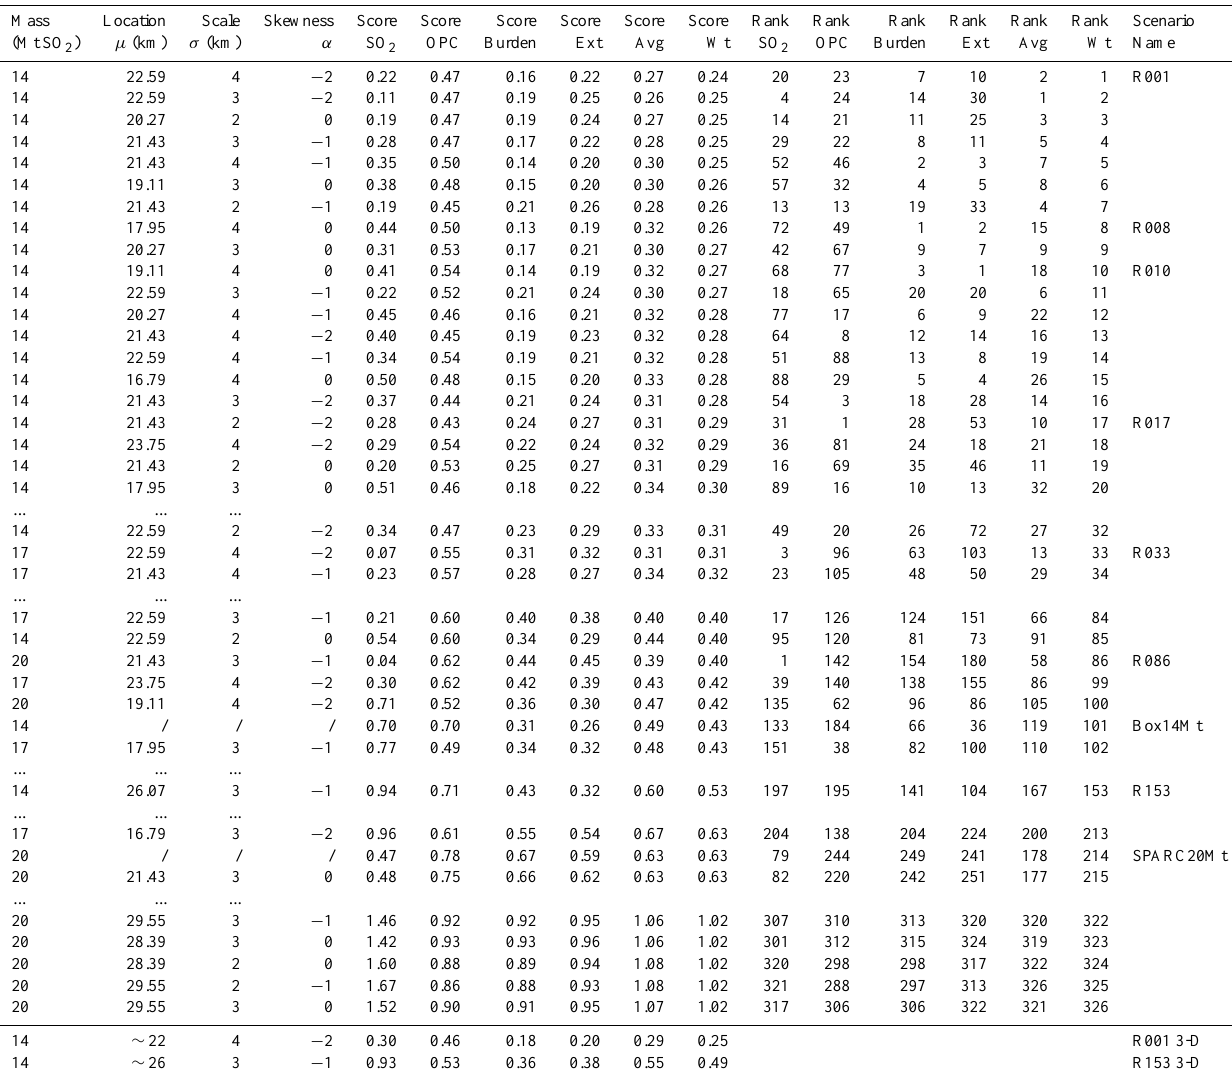
Table 1. Scores and rankings of 326 AER 2-D atmospheric simulations of the Pinatubo eruption sorted according to the weighted rank (“RankWt”). The weighting is given by 16.7% of the SO 2 score (ScoreSO 2 ), 16.7% of the OPC score (ScoreOPC), 33.3% of the global burden score (ScoreBurden), and 33.3% of the aerosol extinction score (ScoreExt). The rank computed by the arithmetic average of the four scores is also provided (“RankAvg”). Scores of two additional 3-D simulations “R001 3-D” and “R153 3-D” from the aerosol–chemistry– climate model SOCOL-AER are provided at the bottom of the table. Mass